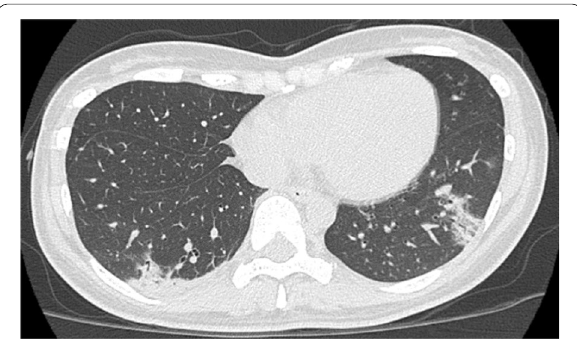
Fig. 1 Chest CT findings. Chest CT findings at the diagnosis of COVID-19 showing ground-glass opacity in the peripheral lesion of both